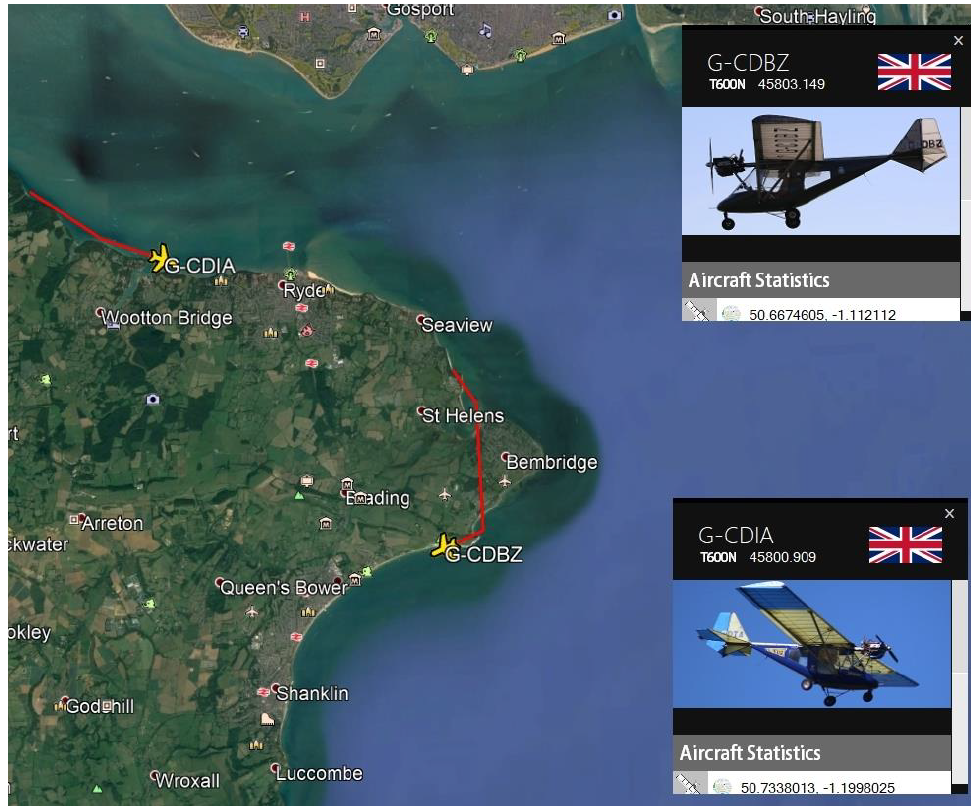
Figure 16. A screenshot of the application with two flight simulated aircraft instances.